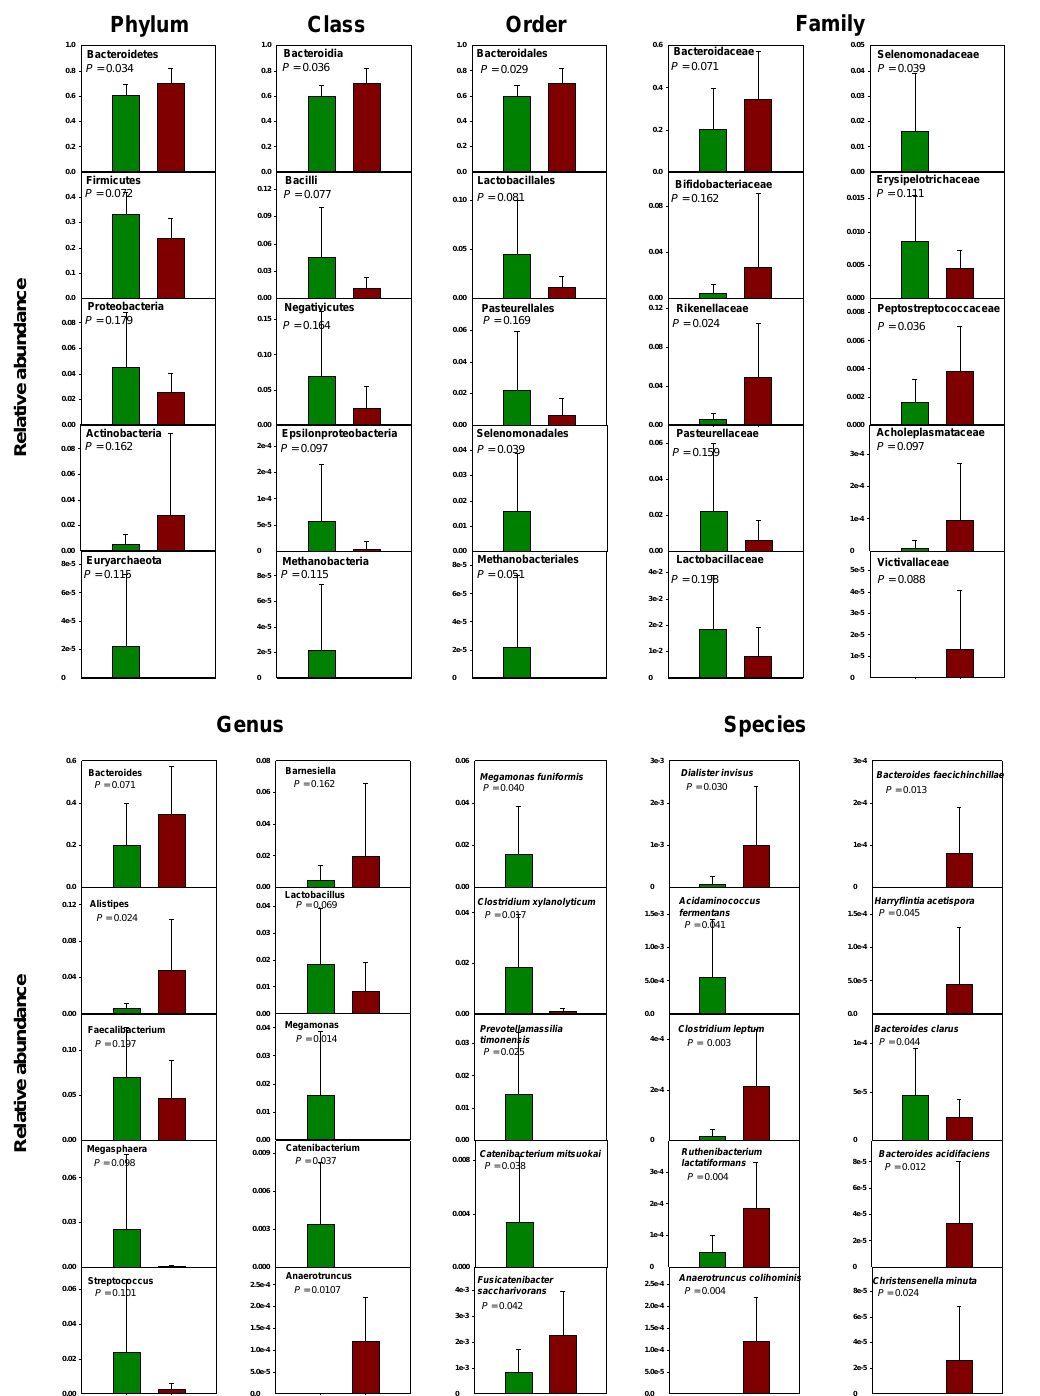
Figure 6. Relative abundance of bacterial taxa varied in the fecal sample from rheumatoid arthritis (RA) and osteoarthritis (OA) patients at the phylum, class, order, family, genus, and species levels. The presented p -value was based on independent samples t -test ( n = 9) for each